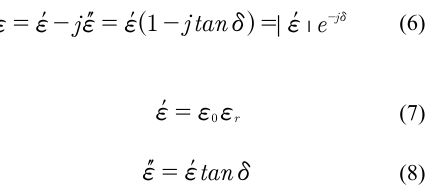
Figure 3. XRD patterns of CaCO